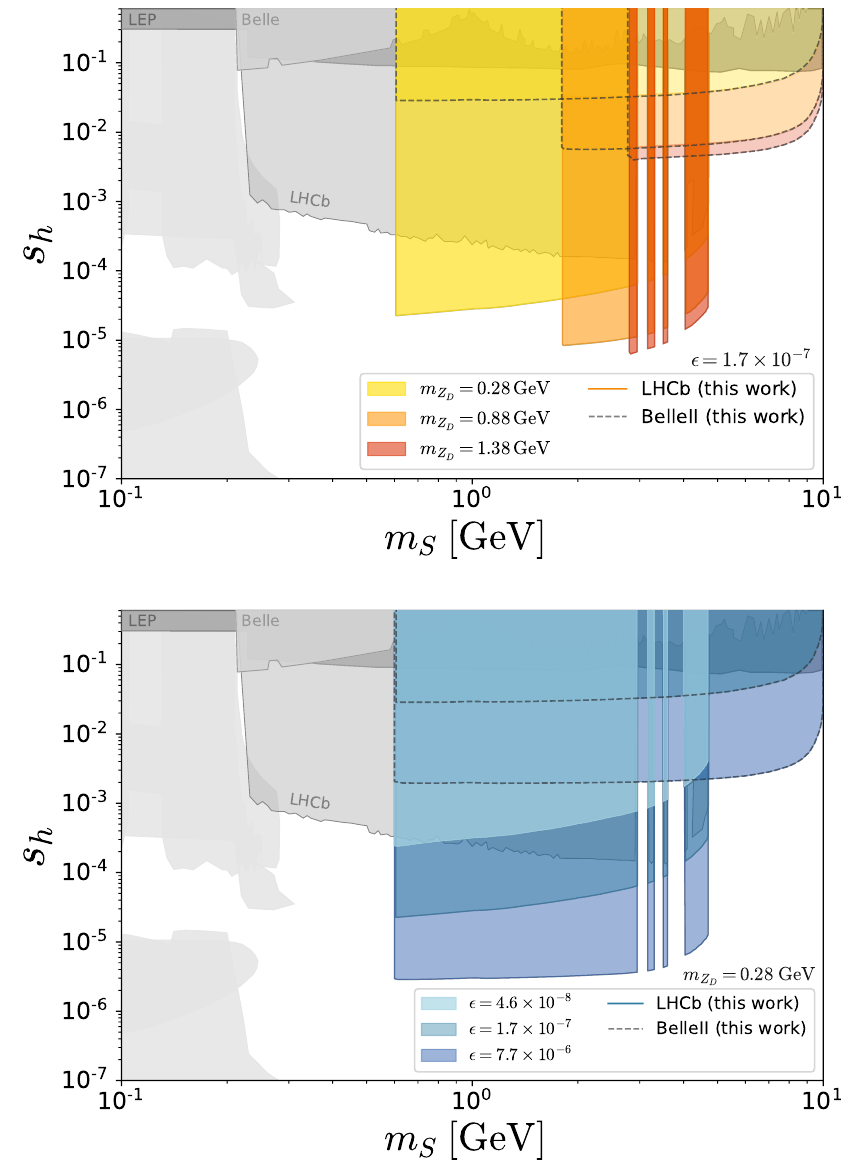
Figure 7 . In the upper panel we show the expected bounds in the m S × s h plane for the LHCb search (solid) and the future sensitivity projection for the Belle II search (dashed). The colors denote different dark photon mass choices, as indicated in the labels. We fixed the kinetic mixing parameter to (cid:15) = 1 . 6 × 10 − 7 . The lower panel shows the same projection, but for a fixed dark photon mass of m Z = 0 . 28 GeV and varying kinetic mixing parameter values according to the labels. In both D figures, the vetoed regions represent the meson resonances that we have considered as irreducible backgrounds and the gray bounds are similar to the ones of figure 4 with the addition of the limits from Belle [26] and LEP